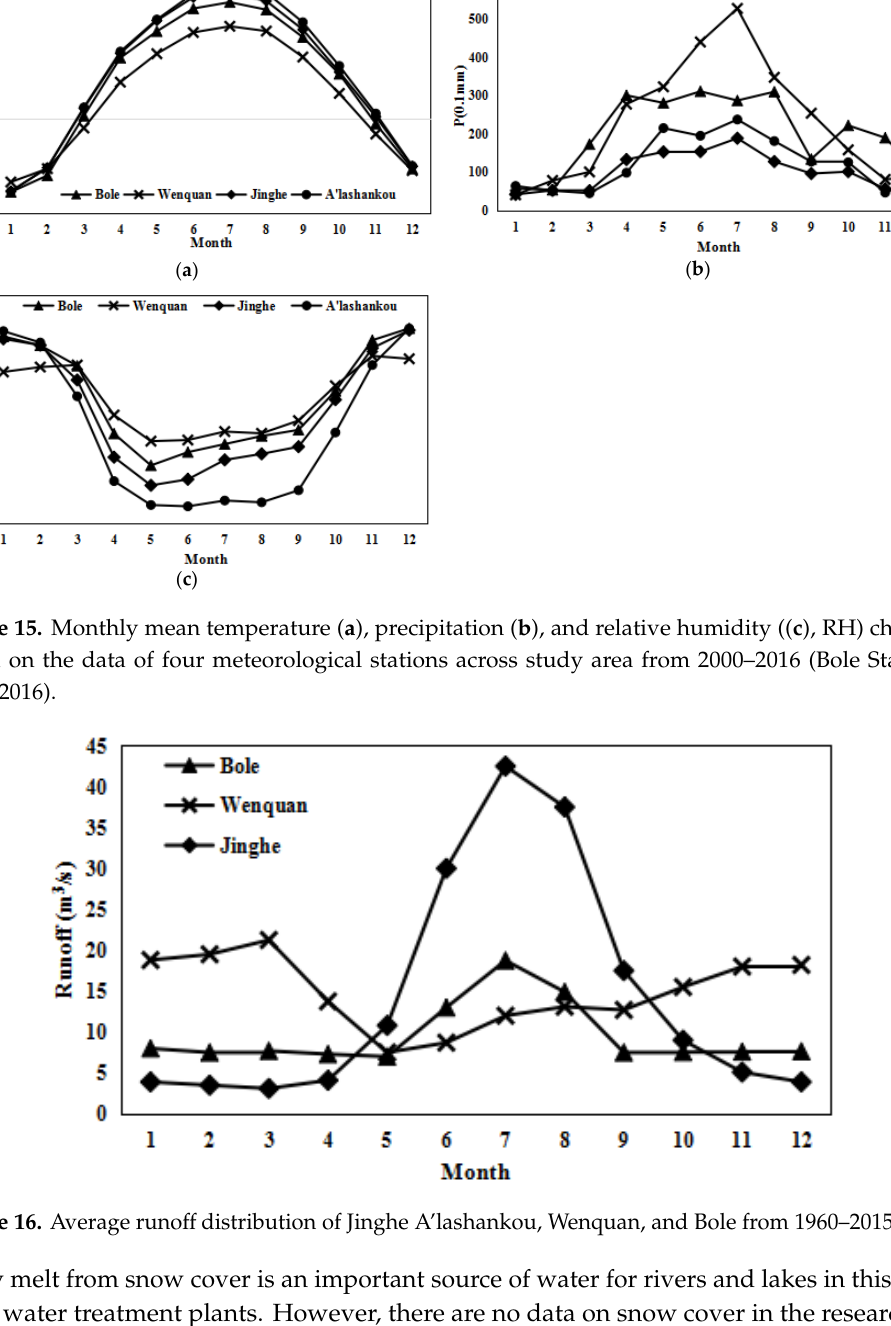
Figure 16. Average runoff distribution of Jinghe A’lashankou, Wenquan, and Bole from 1960 – 2015 [47].